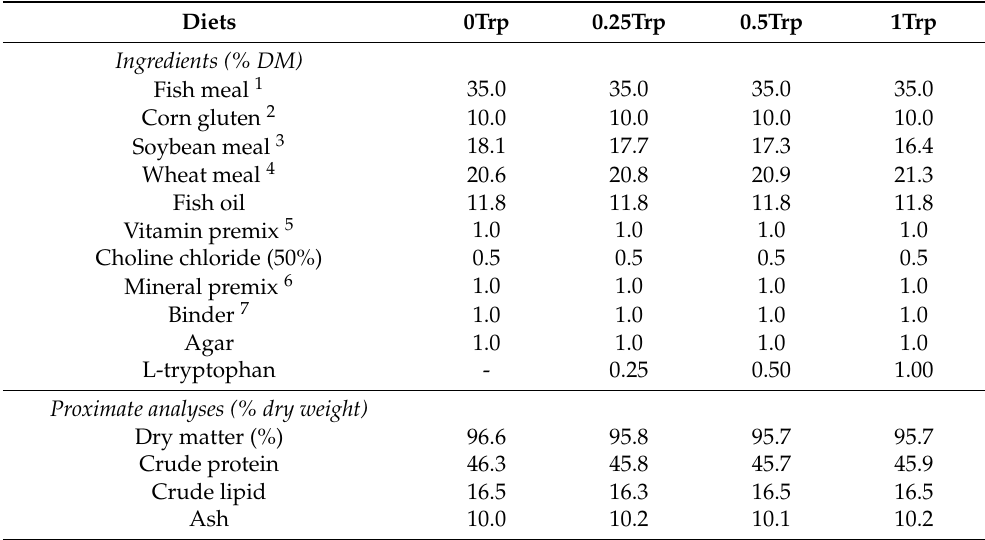
Table 1. Formulation and proximate analyses (% dry matter) of the experimental diets.